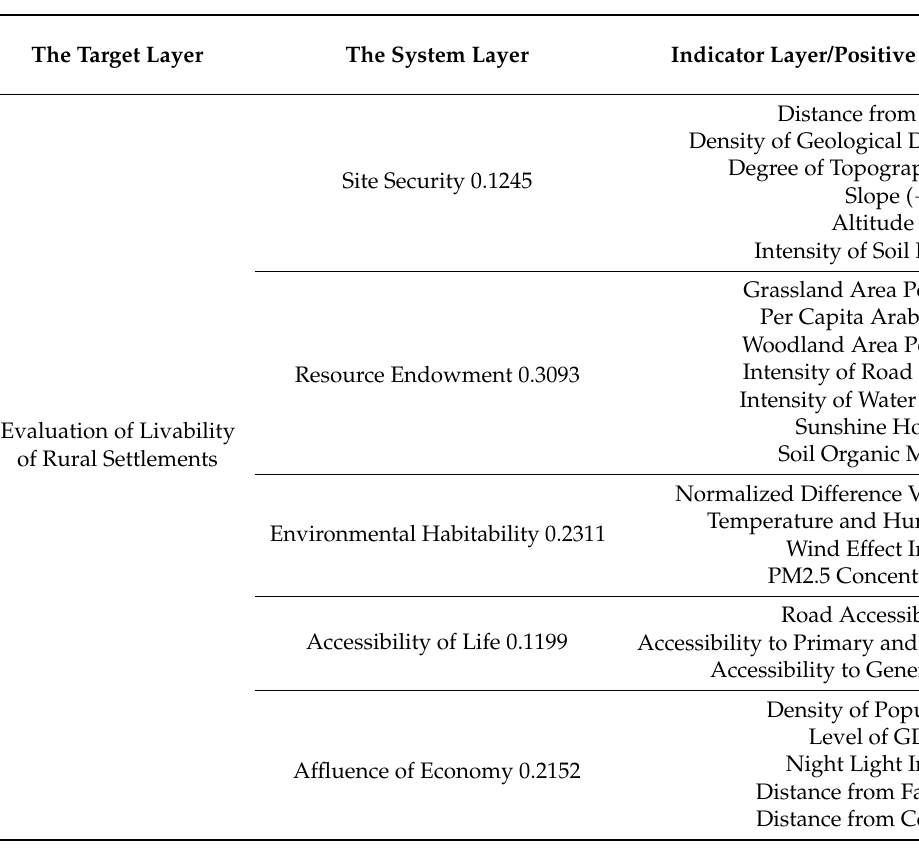
Table 2. Evaluation Index System of Rural Settlement